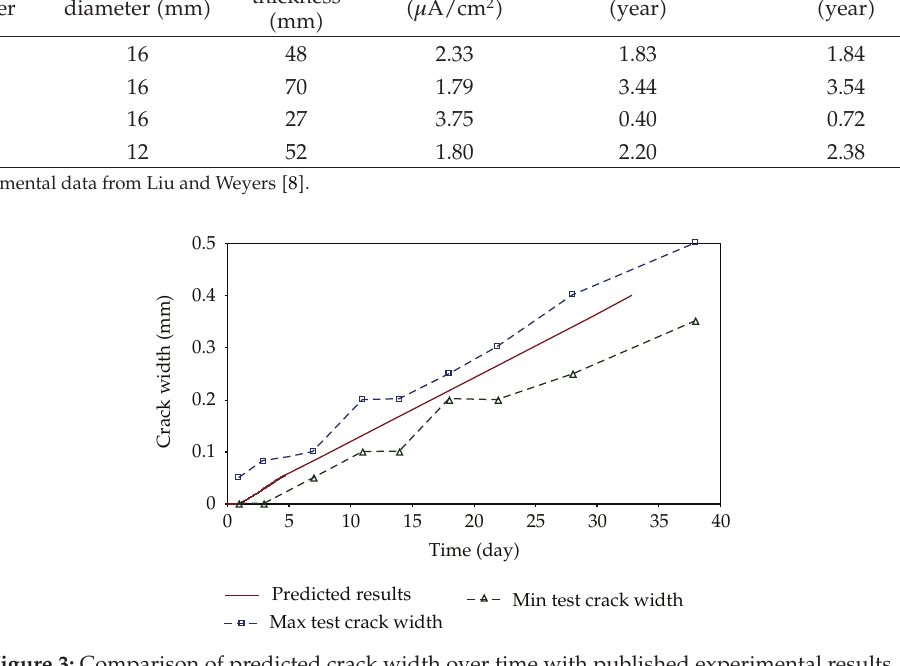
Figure 3: Comparison of predicted crack width over time with published experimental